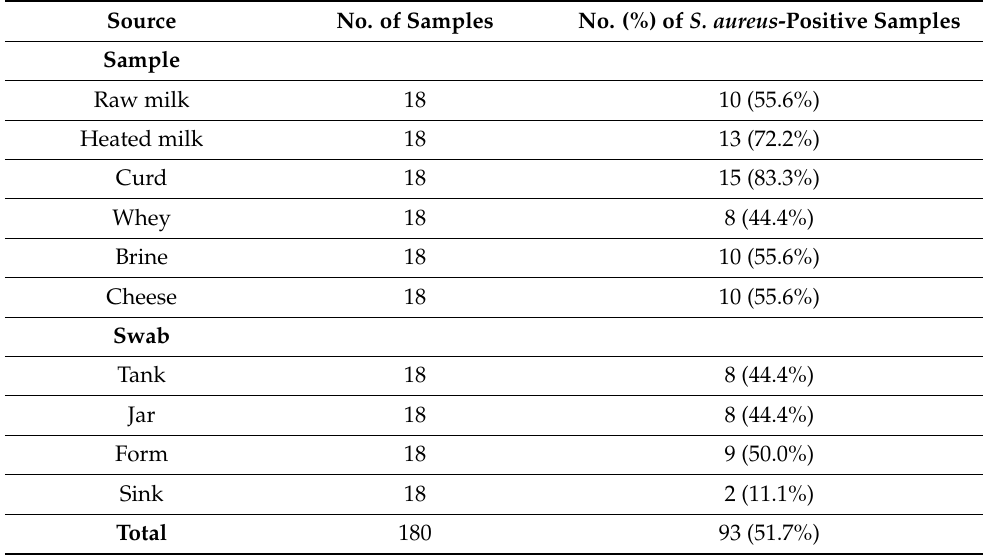
Table 1. Contamination with S. aureus at different stages of cheese production chain. Source No. of